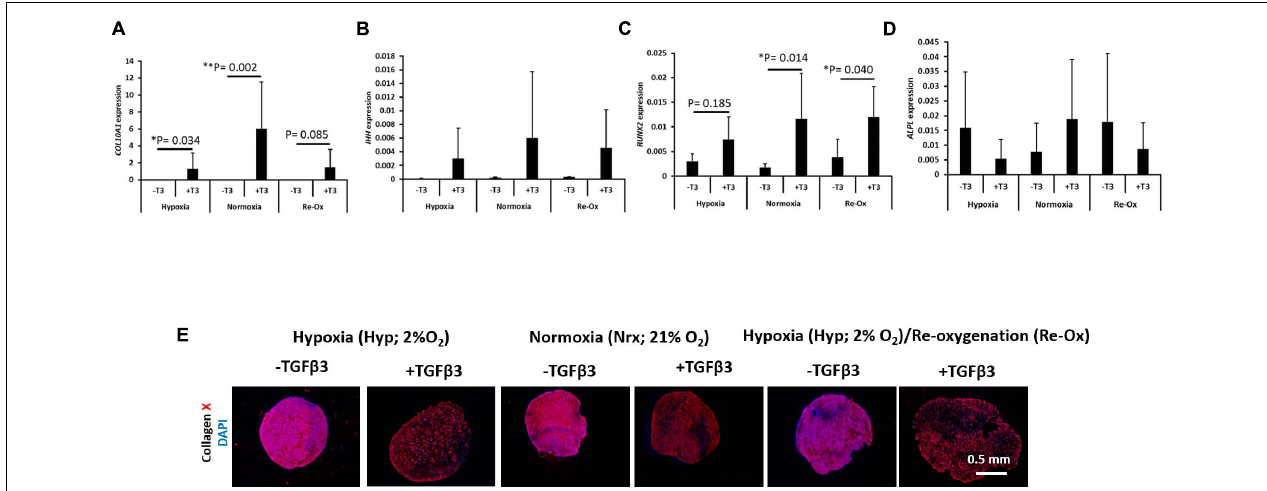
FIGURE 5 | Hypertrophic chondrogenesis marker gene expression and immunofluorescence of type X collagen. Relative mRNA expression of (A) type X collagen ( COL10A1 ), (B) Indian Hedgehog ( IHH ), (C) Runt-related transcription factor 2 ( RUNX2 ), and (D) alkaline phosphatase ( ALPL ) for seven donors with independent duplicates ( N = 7, n = 14 per experimental group). Gene expression was normalized to the geometric mean of three housekeeping genes ( YWHAZ , β -actin , and B2M ). Bar data are mean ± standard deviation. Statistical comparisons were based on Kruskal–Wallis test between without TGF β 3 (i.e., –T3) and with TGF β 3 (i.e., +T3) groups within an oxygen tension group. ∗ p -value < 0.05; ∗∗ p -value < 0.01. (E) Immunofluorescence (IF) for type X collagen and DAPI for cell nuclei. All immunostained pellet sections were prepared at 5 µ m.